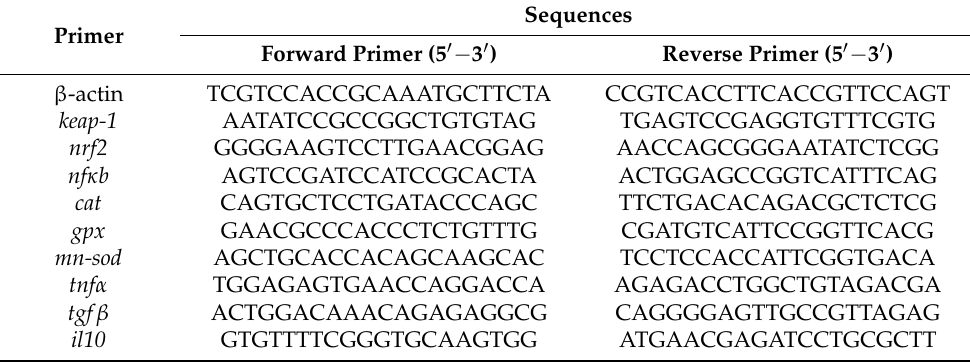
Table 2. Primers used for real-time PCR